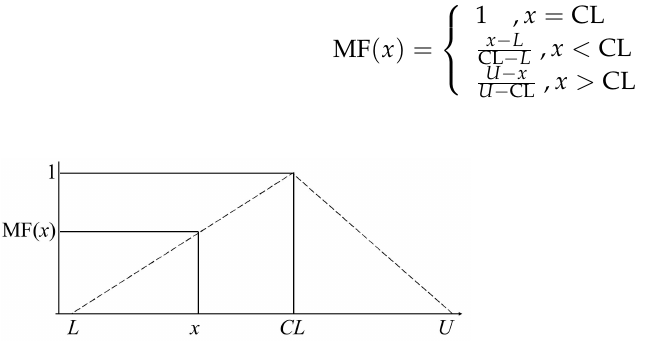
Figure 5. Representing the membership